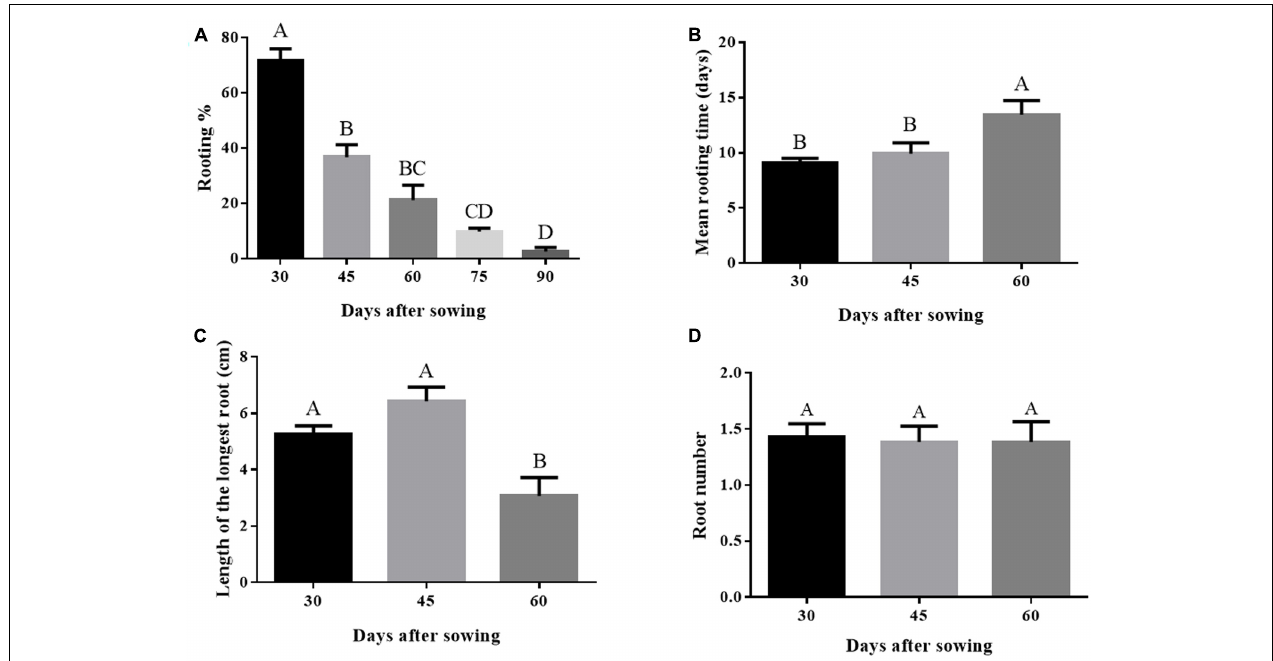
FIGURE 1 | (A–D) Rooting performance in Eucalyptus globulus microcuttings derived from donor plants of different ages after sowing. Bars not sharing a letter are significantly different by Tukey test ( P ≤ 0.05). Values are the means of 2 to 4 independent experiments. Data on graphs (C) and (D) considered only rooted cuttings. Lines on top of bars represent standard errors.